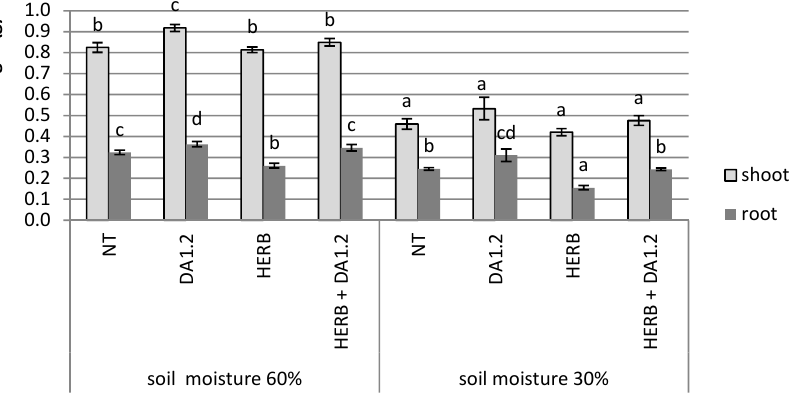
Figure 1. The weight of wheat plant on the 14th day after treatment. NT—no treatment was performed; DA1.2—bacterial treatment with Pseudomonas protegens DA1.2; HERB—herbicide. Statistically different means are indicated by different letters ( p ≤ 0.05, n = 50).